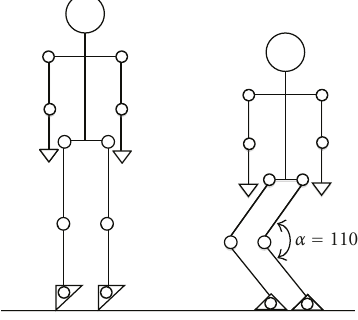
Figure 1: Body postures selected for the study.